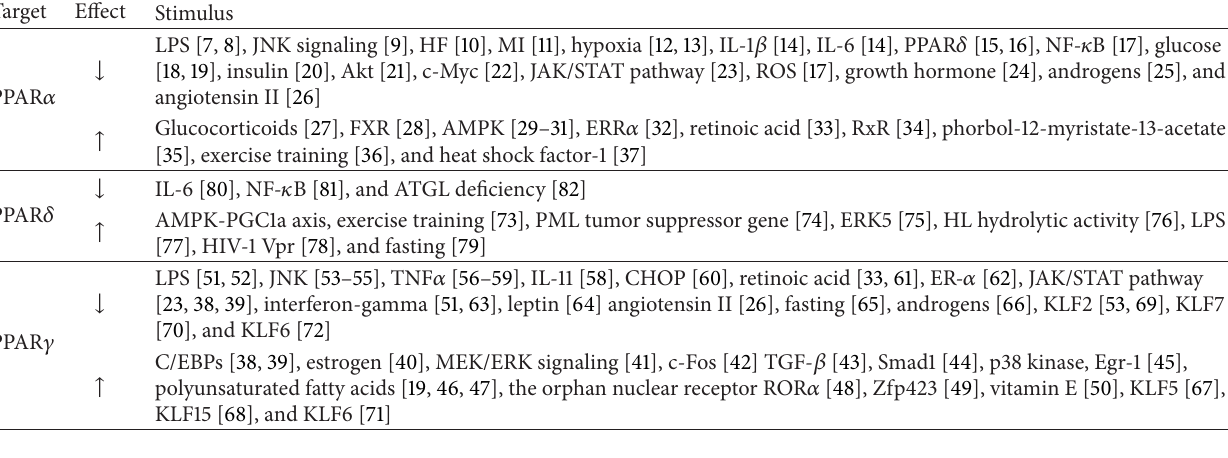
Table 1: Transcriptional regulators of PPARs (see text for acronyms).